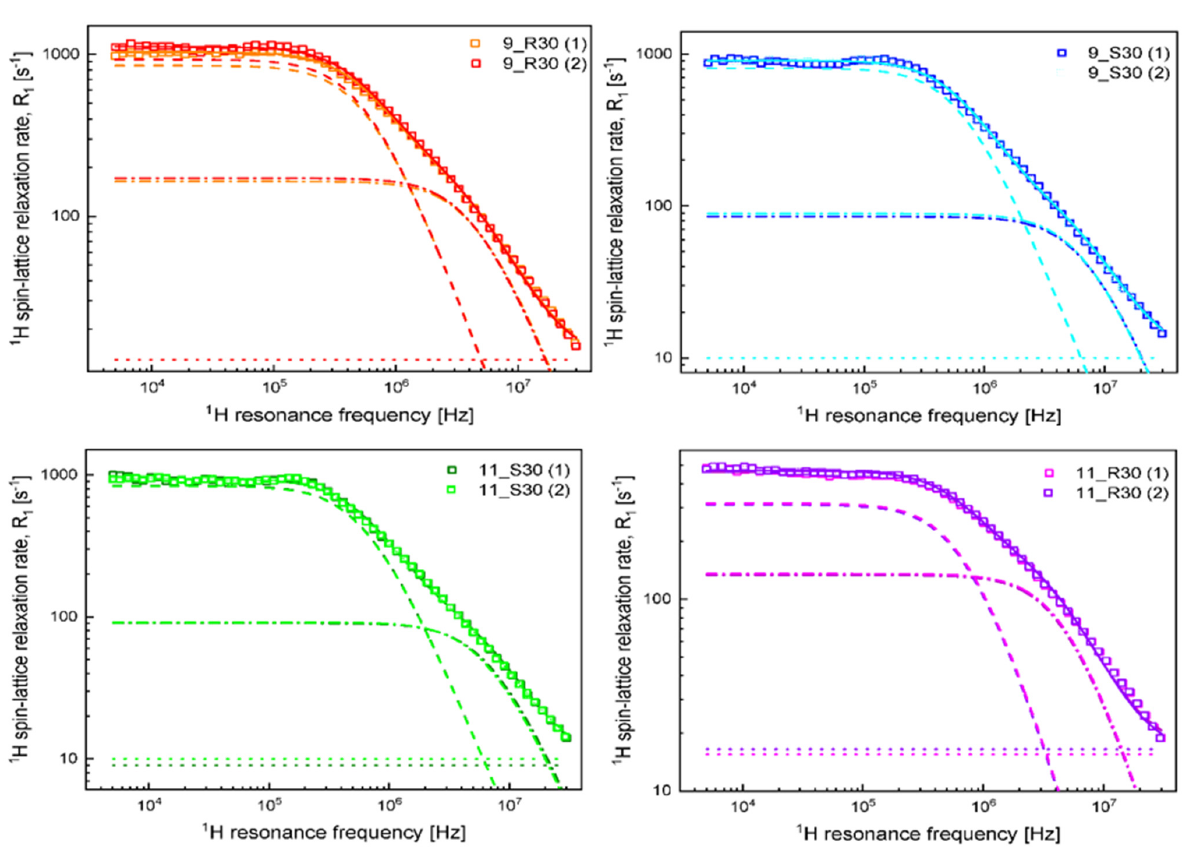
Figure 2. 1 H spin-lattice relaxation data for samples listed in Table 3. Solid lines—fits in terms of Equation (2) decomposed into the relaxation contributions associated with the slow dynamics (dashed lines), fast dynamics (dashed-dotted lines), and the frequency independent term (dotted lines). The obtained parameters are collected in Table 1.